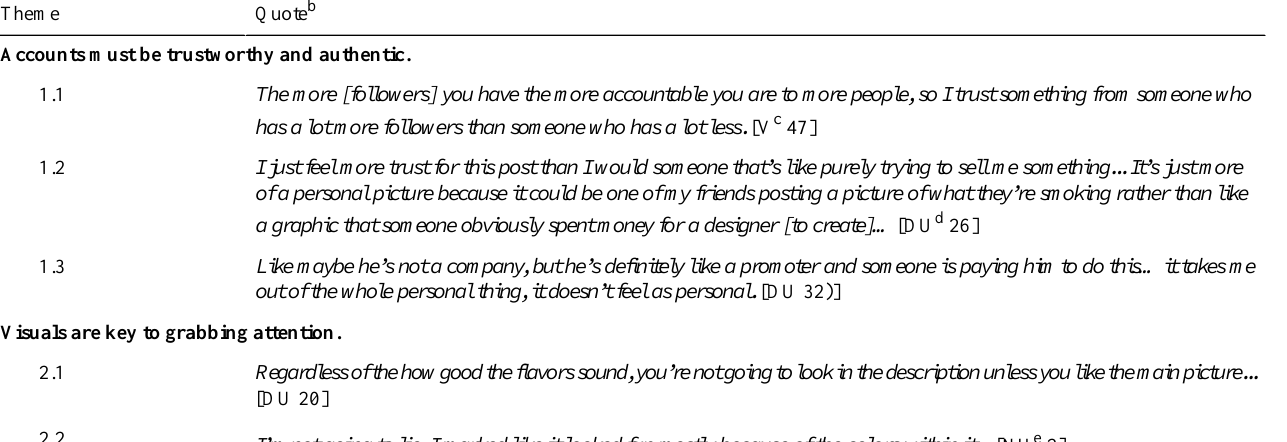
Table 4. Selected quotes highlighting key themes in responses to e-liquid a promotion posts. Quote b Theme Accounts must be trustworthy and